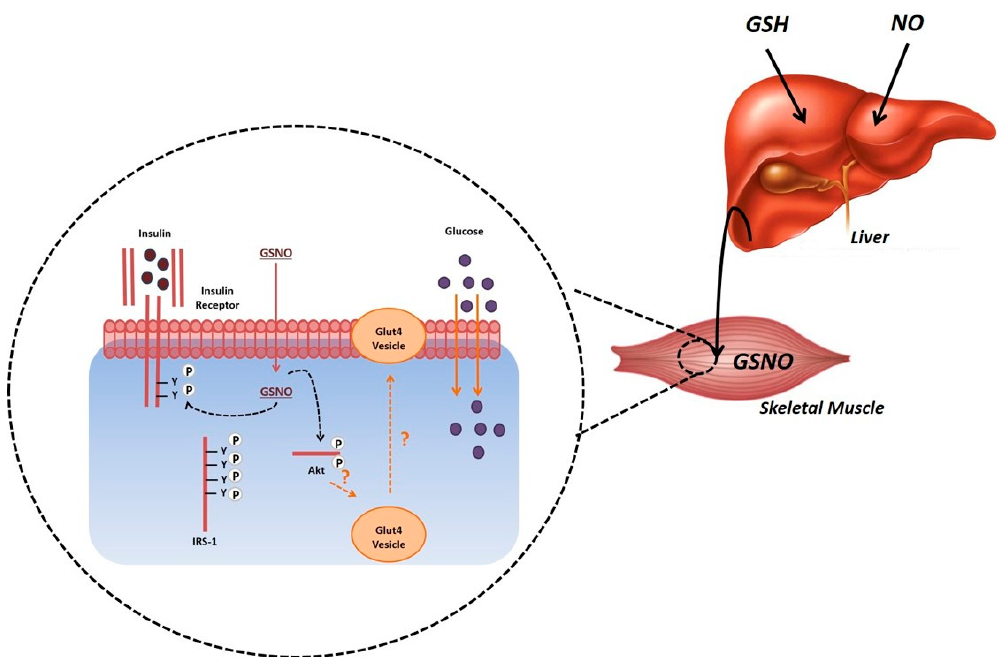
Figure 5. Hepatic production of S-nitrosoglutathione may positively impact insulin sensitive tissues through modulation of the insulin signaling pathway. Abbreviations: GSH - glutathione, GSNO - S-nitrosoglutathione, NO - nitric oxide.